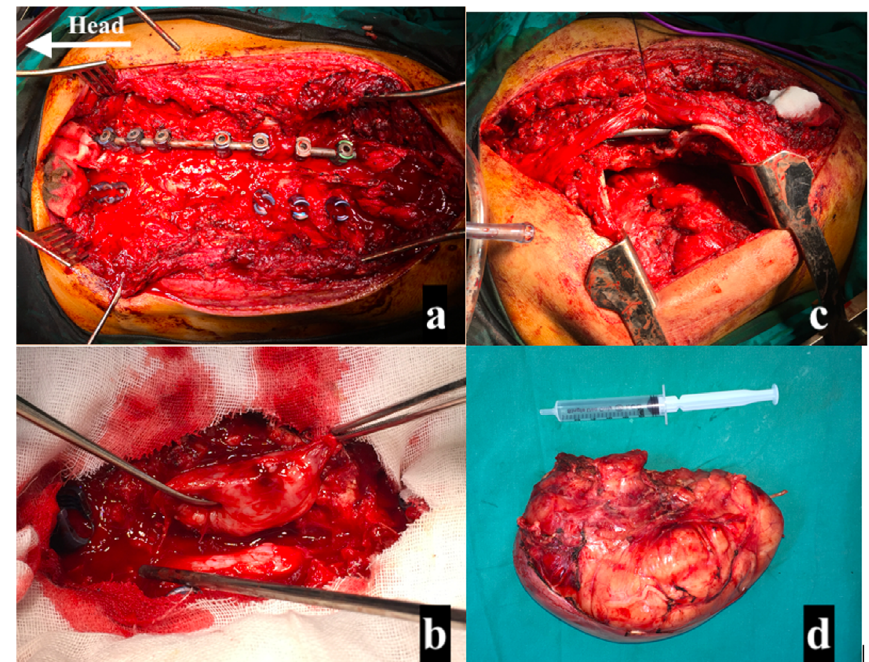
Figure 4. Intraoperative photos. (a) Pedicle screws insertion with rod connected to the right side and microscopic decompression of the spinal cord. (b) Separation of the mass from the cord and ligation of the connecting nerve root and excision of the mass from the spinal cord. (c) Retraction of the para-spinal muscles medially and entering the left hemithorax through the 6th intercostal space posteriorly. (d) The white tumor mass after complete